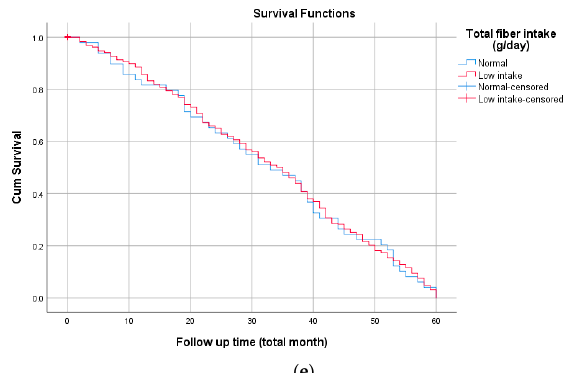
Figure 3. The plot of the estimate of Kaplan-Meier survivor curves of respondents. ( a ) Smoking status, ( b ) fasting blood sugar, ( c ) serum albumin, ( d ) TUG test, and ( e ) fiber intake.